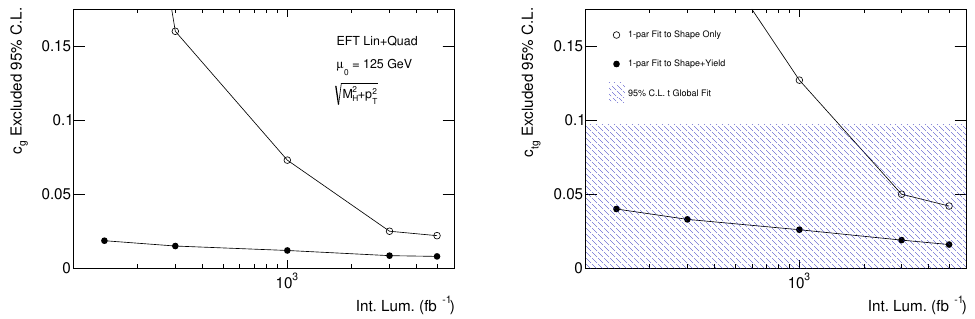
Figure 7. Values of the c g (left) and c tg (right) coefficients excluded at 95% C.L. as a function of the integrated luminosity R L for single-parameter fits. The open points refer to fits to the spectrum shape only and the filled point to fits including also the Higgs signal yield normalised to the SM. The shaded horizontal strip in the right plot indicates the 95% C.L. interval for c tg from the current top quark fit of ref. [71] translated to our definition of c tg ( µ 0 )